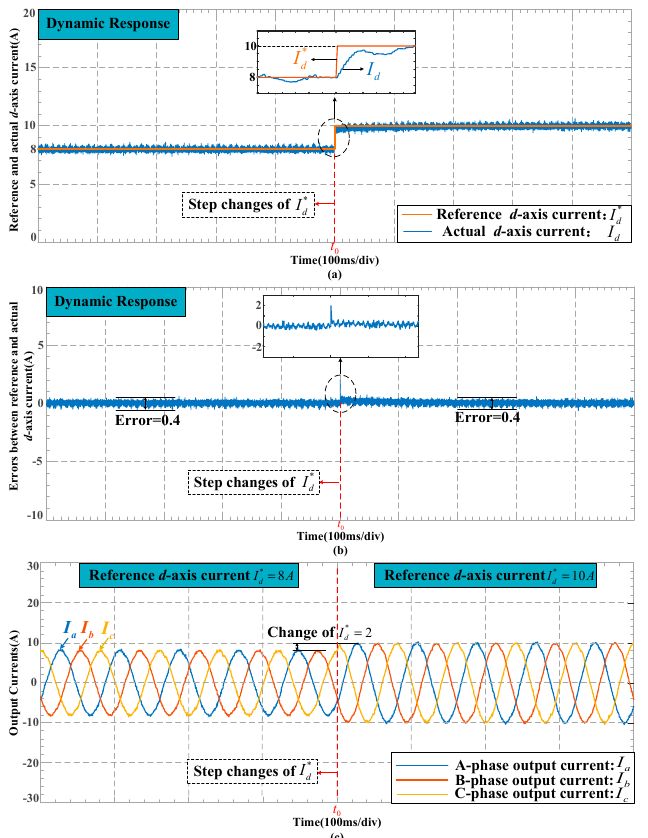
Figure 7. A-phase grid voltage and A-phase output current.